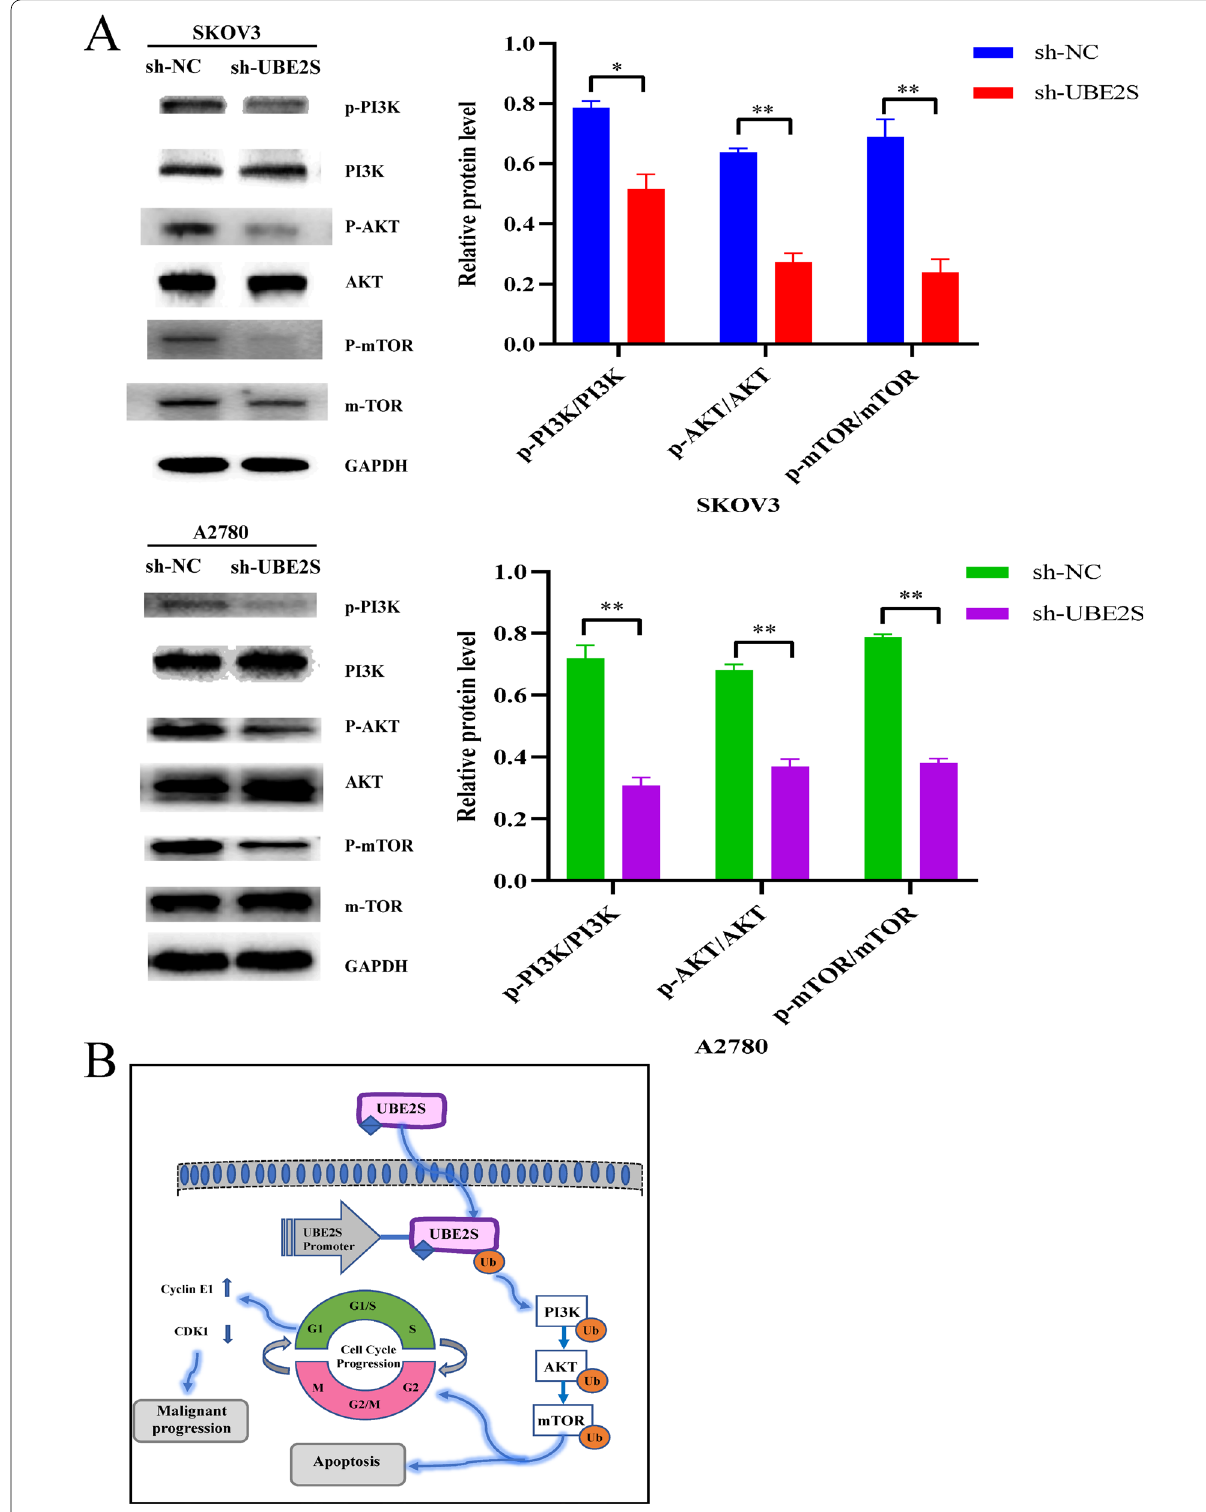
Fig. 12 Western blotting results of PI3K/AKT/mTOR pathway related to UBE2S gene knockdown. A Western blotting results and statistics of p-PI3K/ PI3K, p-AKT/AKT and p-mTOR/mTOR in SKOV3 and A2780 cell line. B The schematic diagram of the underlying mechanism of the UBE2S gene involved in regulating the malignant phenotype of OV based on this